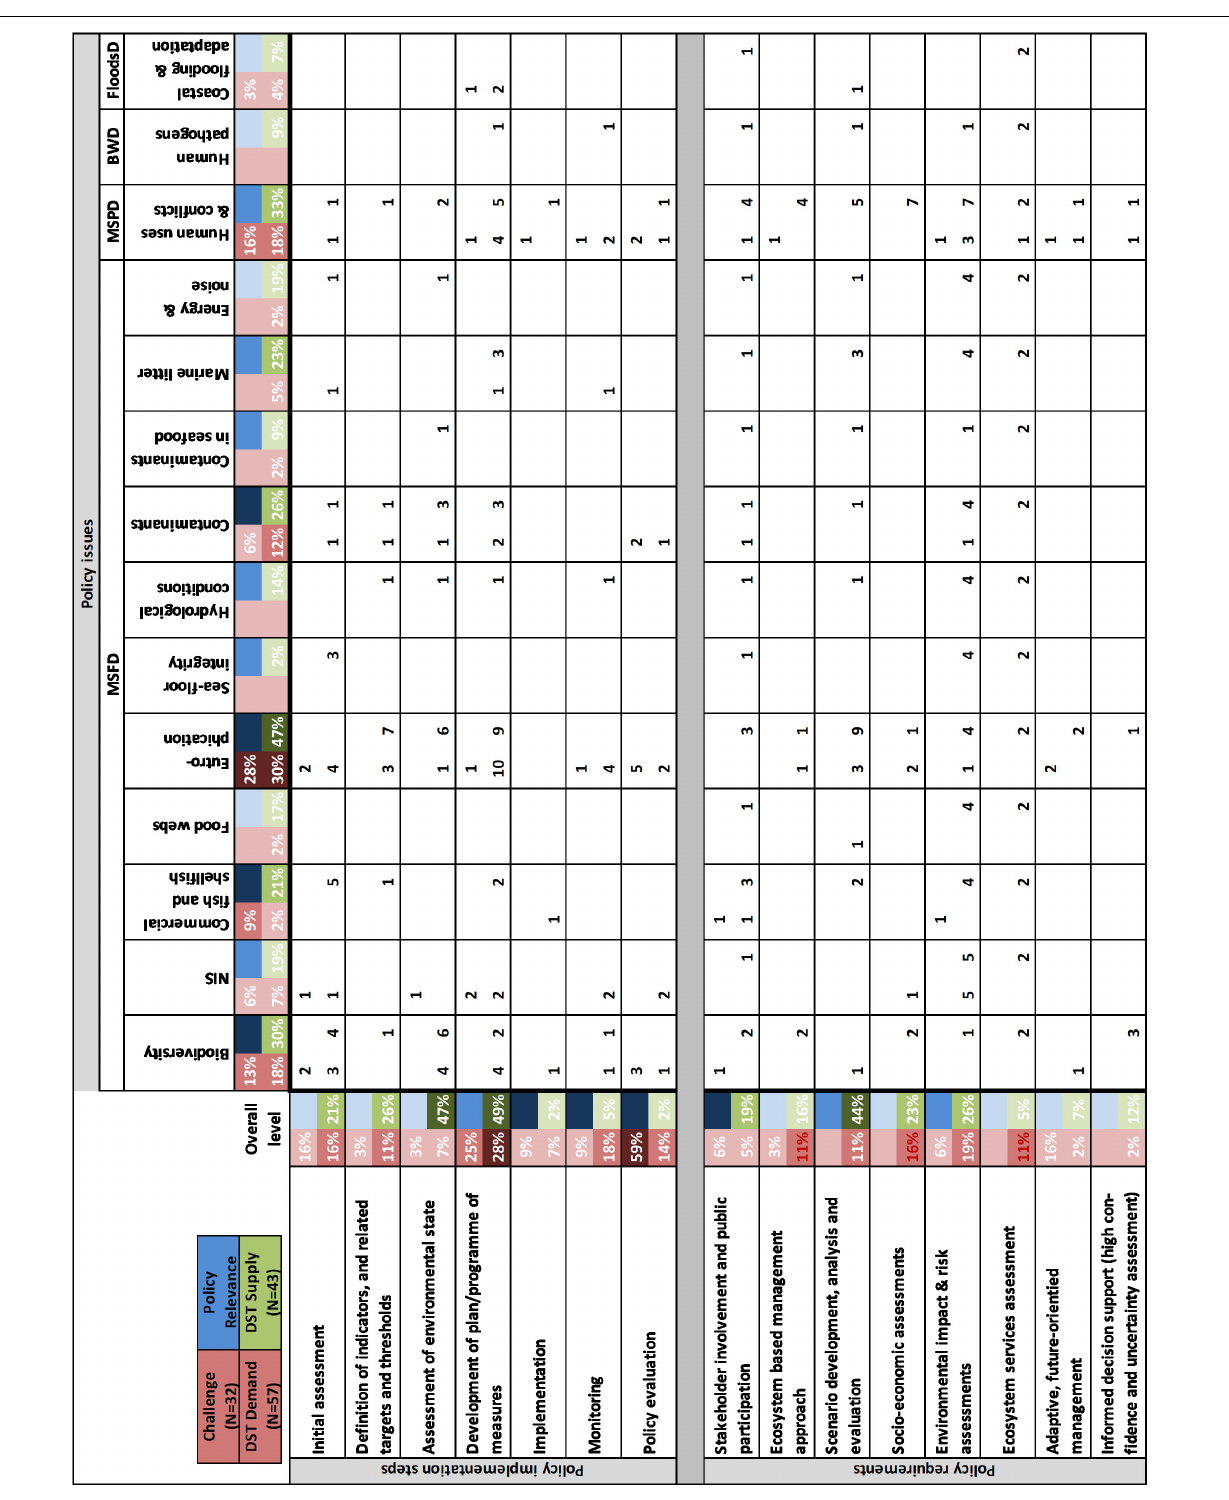
Frontiers in Marine Science |